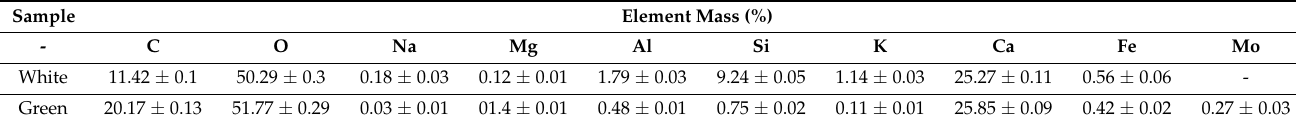
Table 2. The EDS compositions for white and green